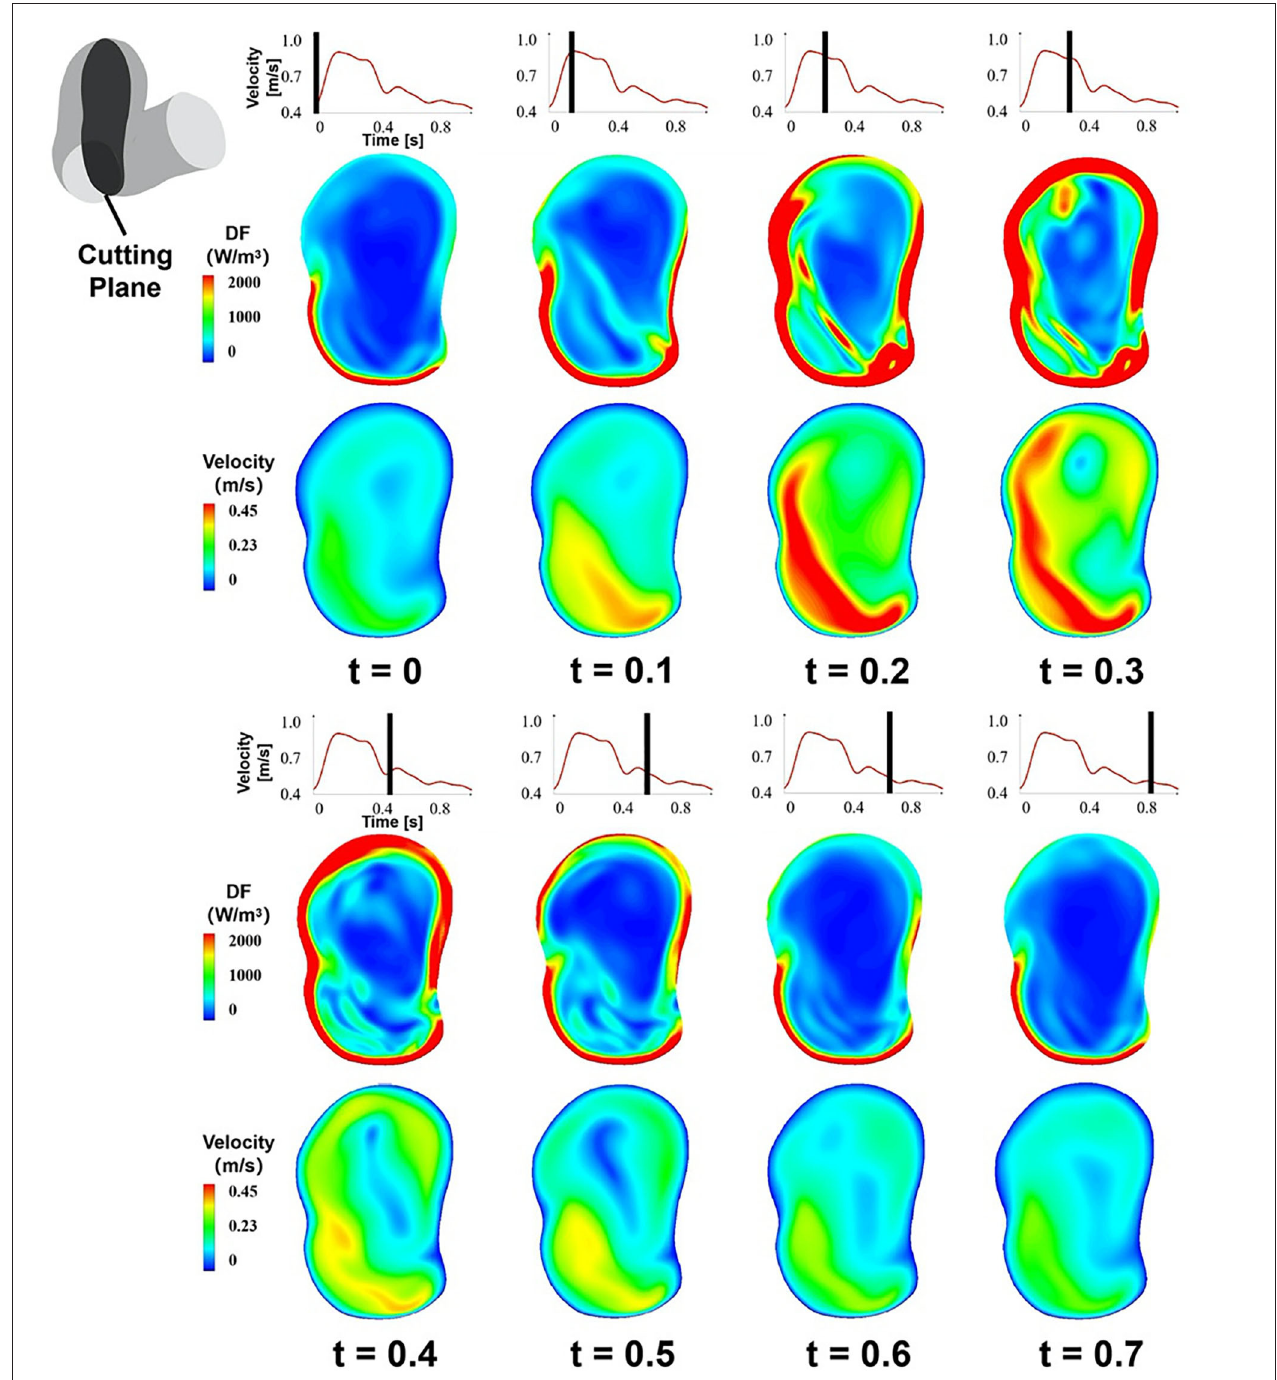
FIGURE 4 | The temporal characteristics of EL, the DF of the cutting plane B during a cardiac circle.